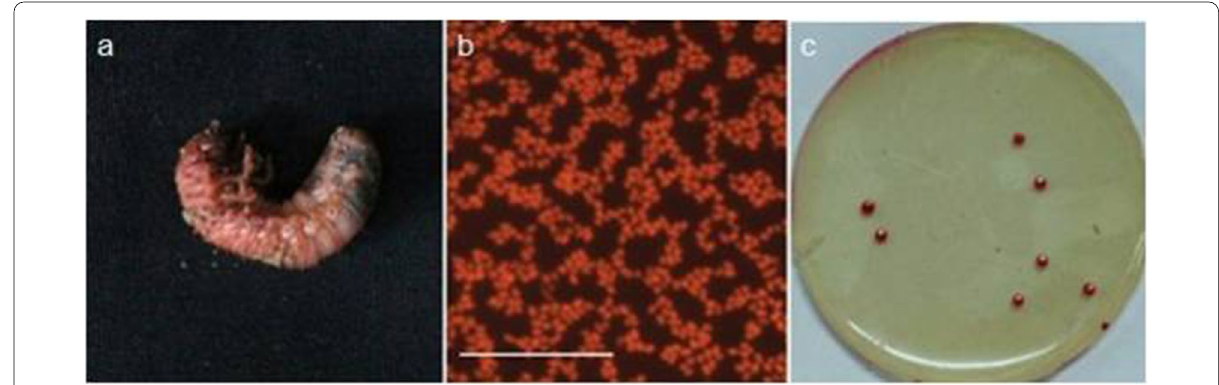
Fig. 1 Symptoms of infection by S. marcescens TC‑1 and morphological characteristics of strain TC‑1. a Symptoms of TC‑1 infection in white grub; b TC‑1 bacterial cells (scale bar 10 μm); c TC‑1 rose red colonies grown on a BPYDA plate (7 mm in diameter) after 48 h at 28 ℃ =